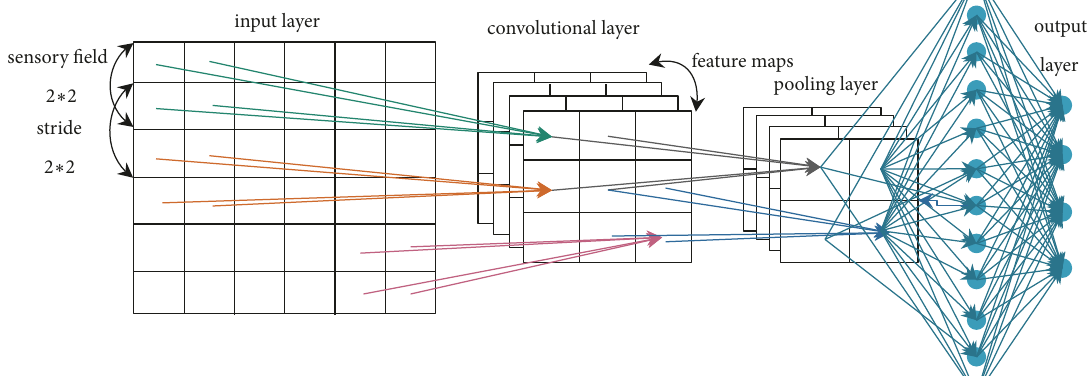
Figure 2: The architecture of CNNs.